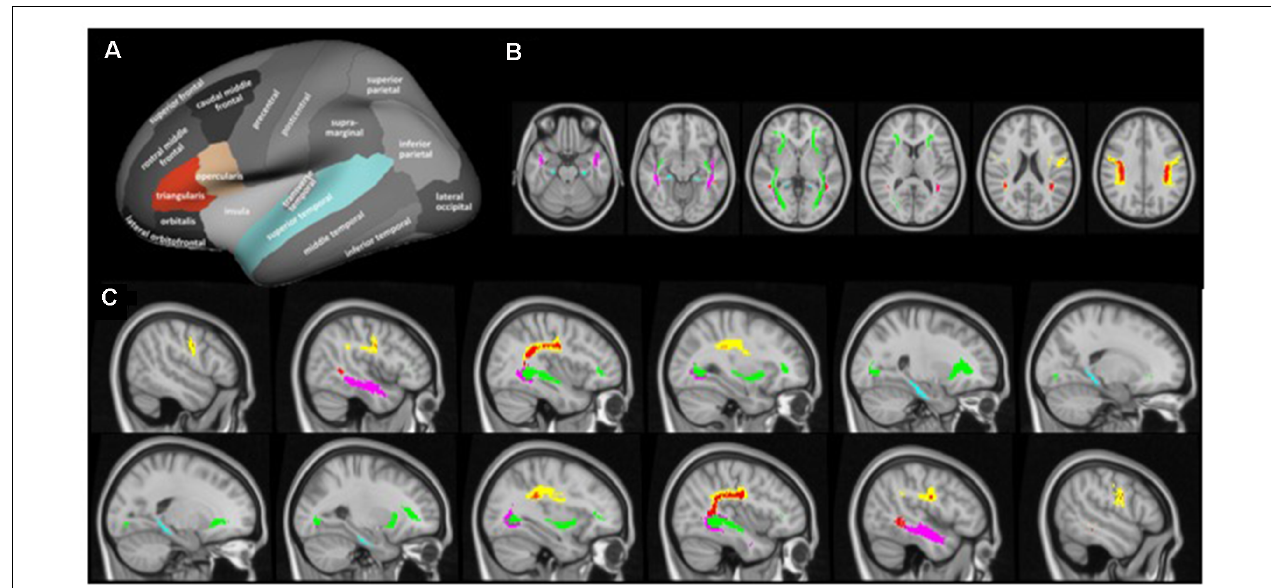
FIGURE 2 | Cortical regions of interest (A) and white matter tracts of interest from axial (B) and sagittal direction (C) . Cortical regions of interest included the pars triangularus (red) and the pars opercularis (beige), both representative of the inferior frontal gyrus, and the superior temporal gyrus (blue), as indicated by the colored parcels in the Desikan-Killiany parcellation map (image modified with permission from Desikan et al., 2006). Note that the hippocampus was included as a region of interest but as a subcortical region is not depicted here. White matter tracts of interest included the superior longitudinal fasciculus (SLF; yellow), temporal component of the SLF (red), inferior longitudinal fasciculus (ILF; pink), inferior fronto-occipital fasciculus (green), and cingulum hippocampal (HC) part (blue), as defined in the JHU DTI-based white-matter atlas (Wakana et al., 2007), displayed on axial (MNI = 50, 60, 71, 82, 93, 103) and sagittal slices (MNI = ± 19, 25, 32, 38, 45,